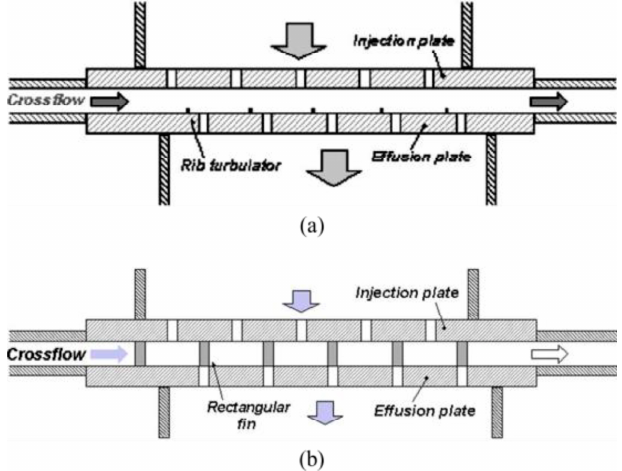
Figure 23. Double-wall cooling with initial crossflow: ( a ) ribs installed on the effusion plate (reprinted with permission from [111], copyright 2004 ASME) and ( b ) pins installed between impingement and effusion plates (reprinted with permission from [112], copyright 2007 ASME).